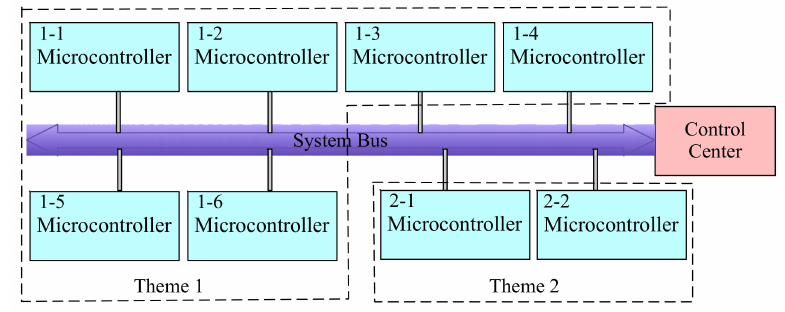
Figure 9. The distributed game system.